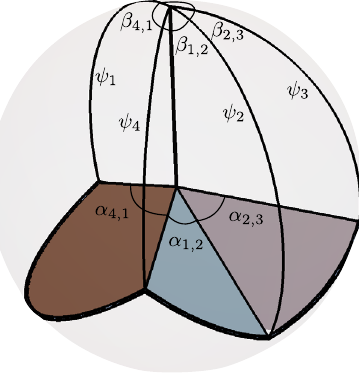
FIG. 11. The spherical polygon spanned by a single vertex. The angle between a fold and the ˆ z axis is ψ adjacentfoldsintheplaneis α folds at the north pole is β